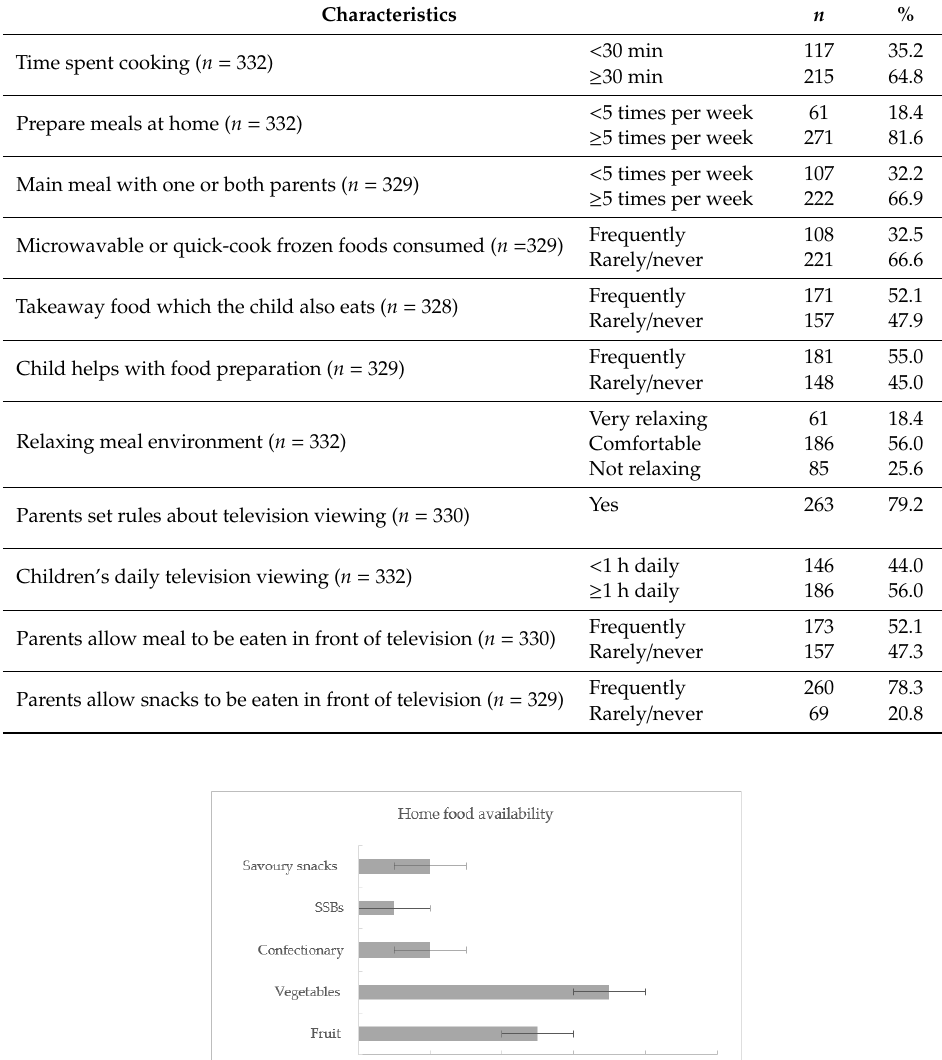
Table 3. Participants’ behavioral characteristics.